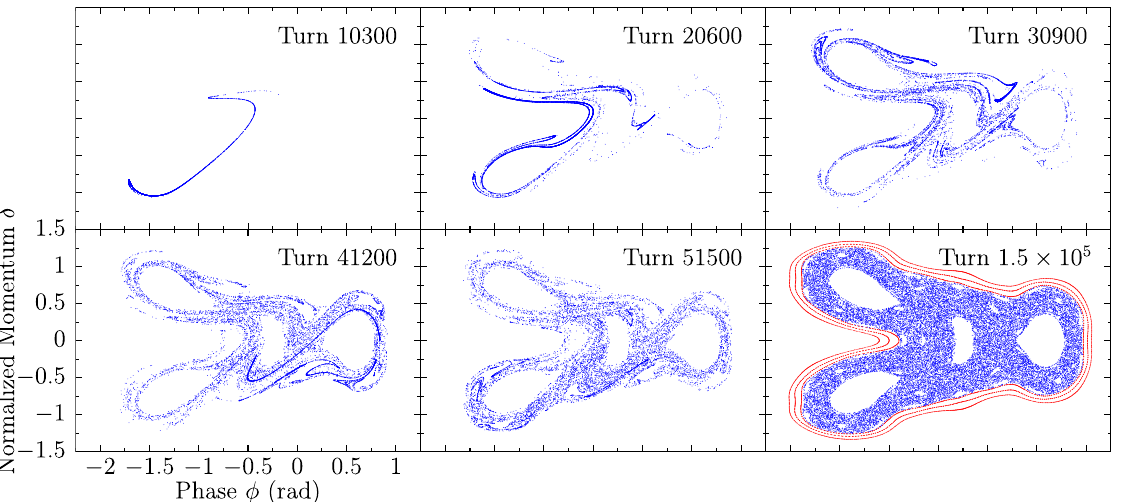
FIG. 10. The evolution of the small bunch of 1 × 10 4 particles with initial rms length σ ϕ ¼ 1 × 10 − 3 rad and momentum spread σ ¼ 1 × 10 − 3 as it undergoes the diffusion process where r ¼ 1 = 2 , h ¼ 2 , a δ smoothly streaming about the 3 ∶ 1 resonant islands as the diffusion evolves until equilibration at about 1 . 5 × 10 5 revolutions. The red points represent particle tracking in the well-behaved bounding tori